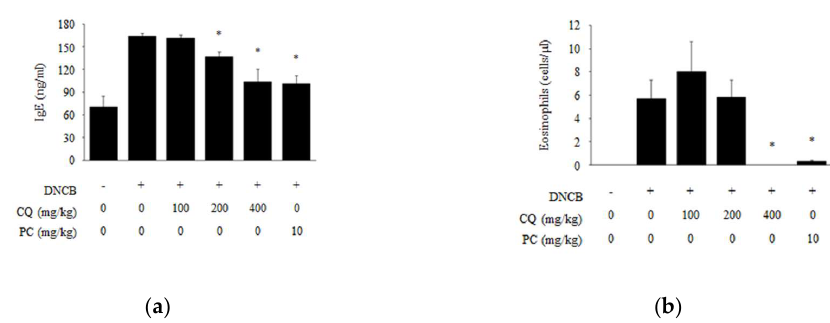
Figure 4. The expression of immunoglobulin E (IgE) and eosinophils in DNCB-induced BALB/c mice. ( a ) To demonstrate the effect of CQ in DNCB-induced BALB/c mice, blood was collected and serum was separated at the end of the experiment. The serum IgE level was analyzed with ELISA; ( b ) The number of eosinophil in whole blood was counted randomly. The mice were randomly divided into six groups: normal, DNCB, and DNCB + CQ (100, 200, and 400 mg/kg) and DNCB + PC 10 mg/kg for 6 weeks. All data are presented as mean ± SD; * p < 0.05 vs. DNCB-induced group.